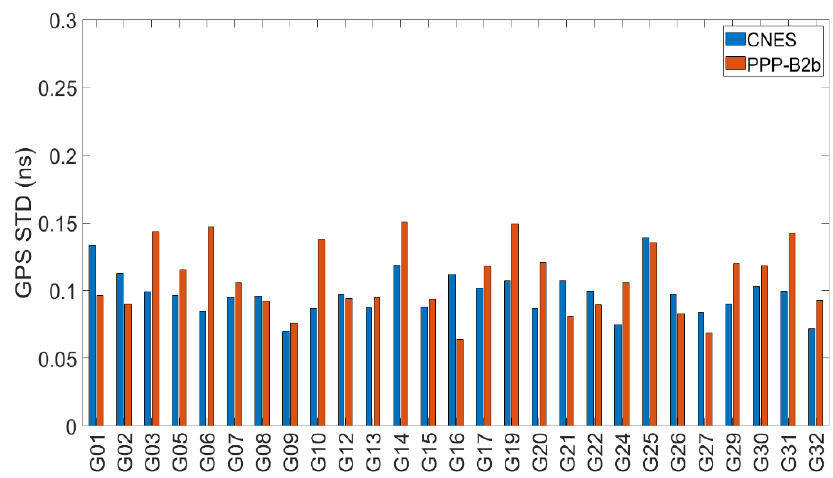
Figure 9. STD values of GPS clock errors for the PPP-B2b and CNES products.